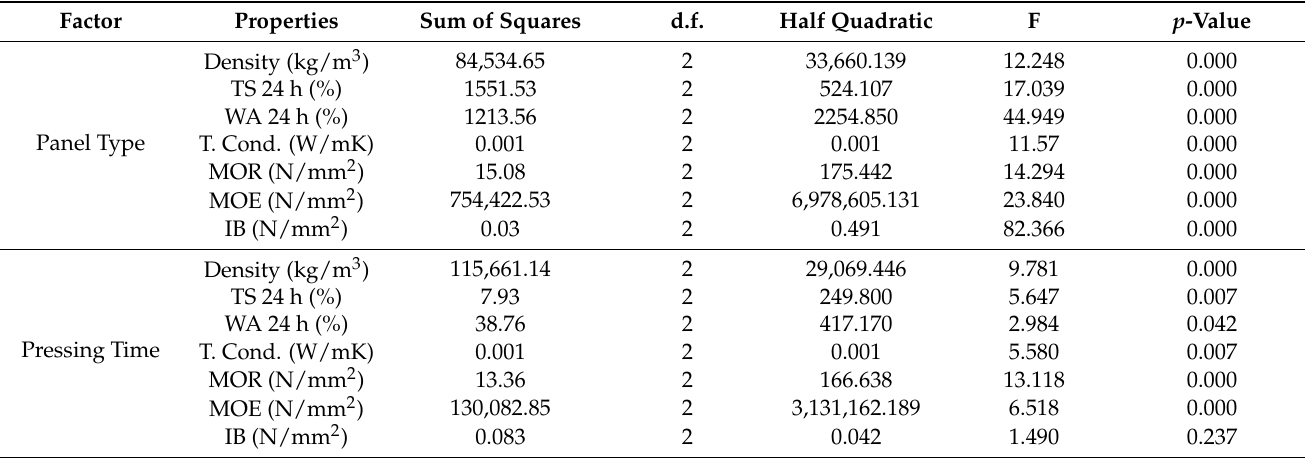
Table 3. ANOVA of the results of the tests.